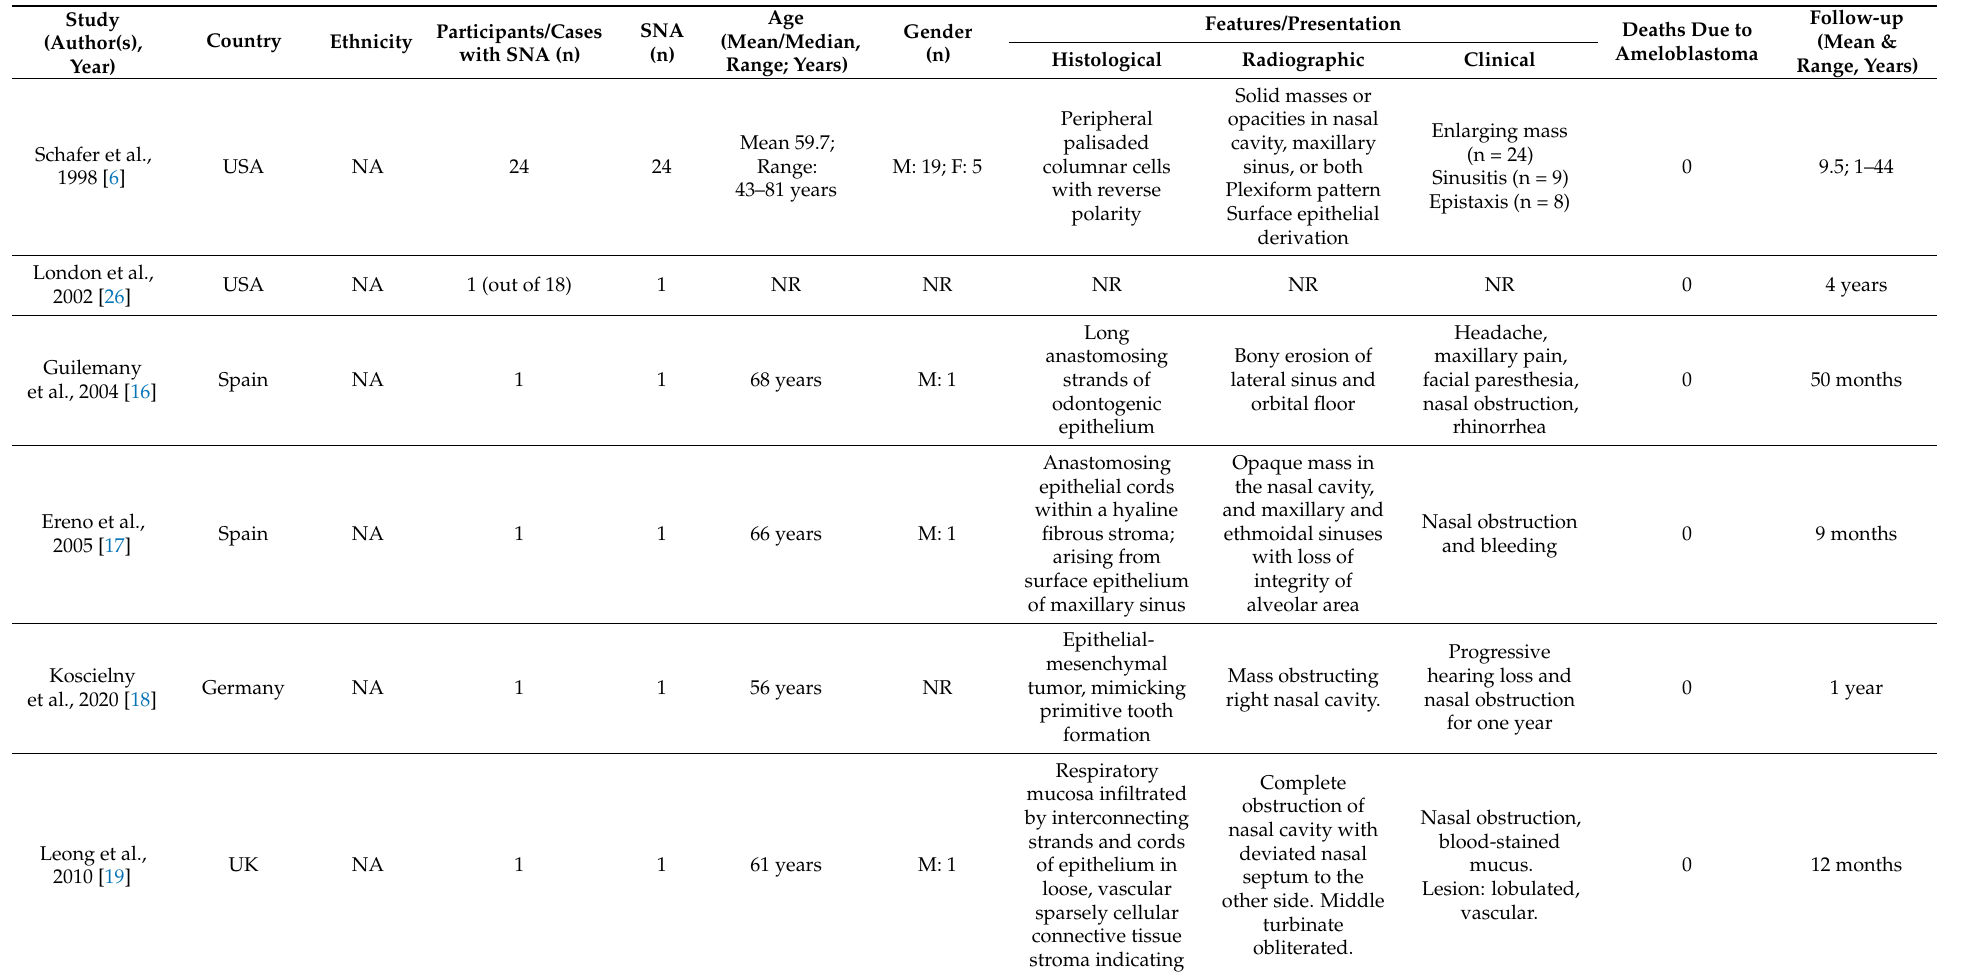
Table 1. Overview of included